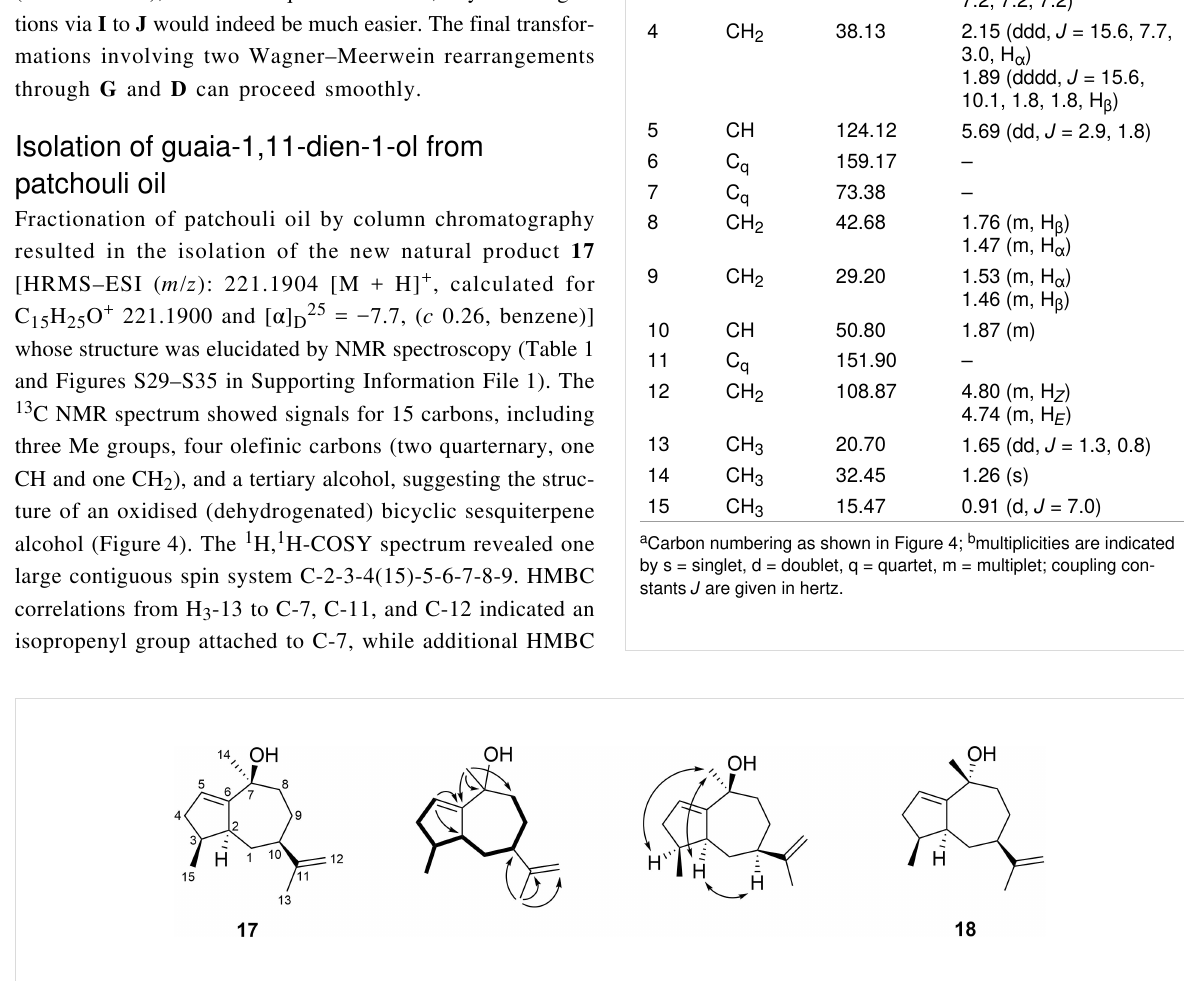
Figure 4: Structure elucidation of (2 S ,3 S ,7 S ,10 R )-guaia-1,11-dien-10-ol ( 17 ) and structure of its known stereoisomer (2 S ,3 S ,7 R ,10 R )-guaia-1,11- dien-10-ol ( 18 ). Bold lines indicate 1 H, 1 H-COSY correlations, single-headed arrows indicate key HMBC correlations and double-headed arrows key NOESY correlations.